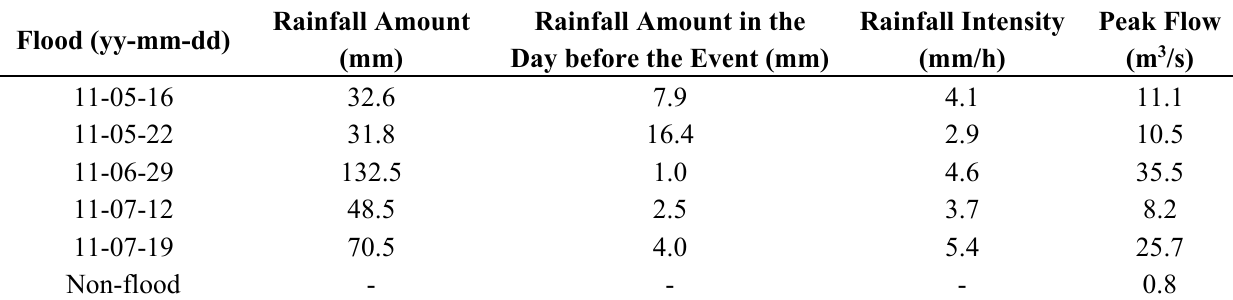
Table 1. The rainfall runoff characteristics of monitored flood